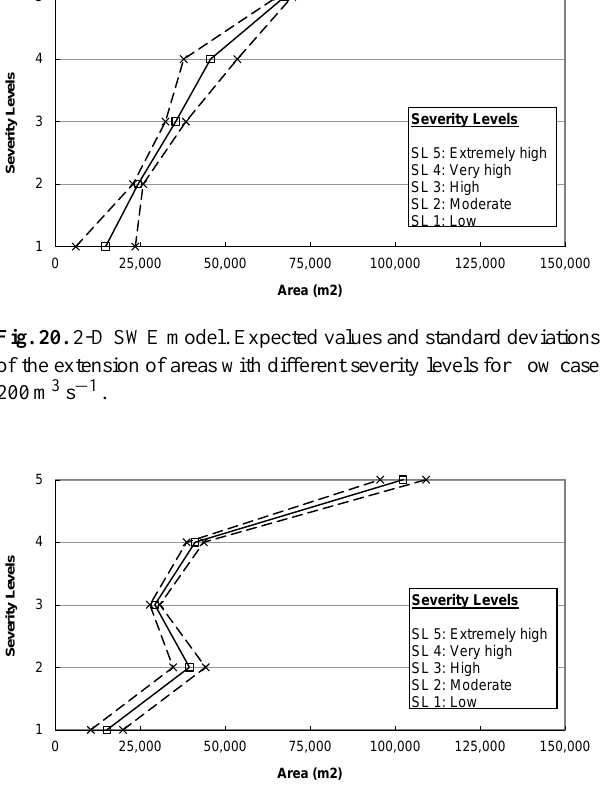
Fig. 21. 2-D SWE model. Expected values and standard deviations of the extension of areas with different severity levels for flow case 300m 3 s − 1 .